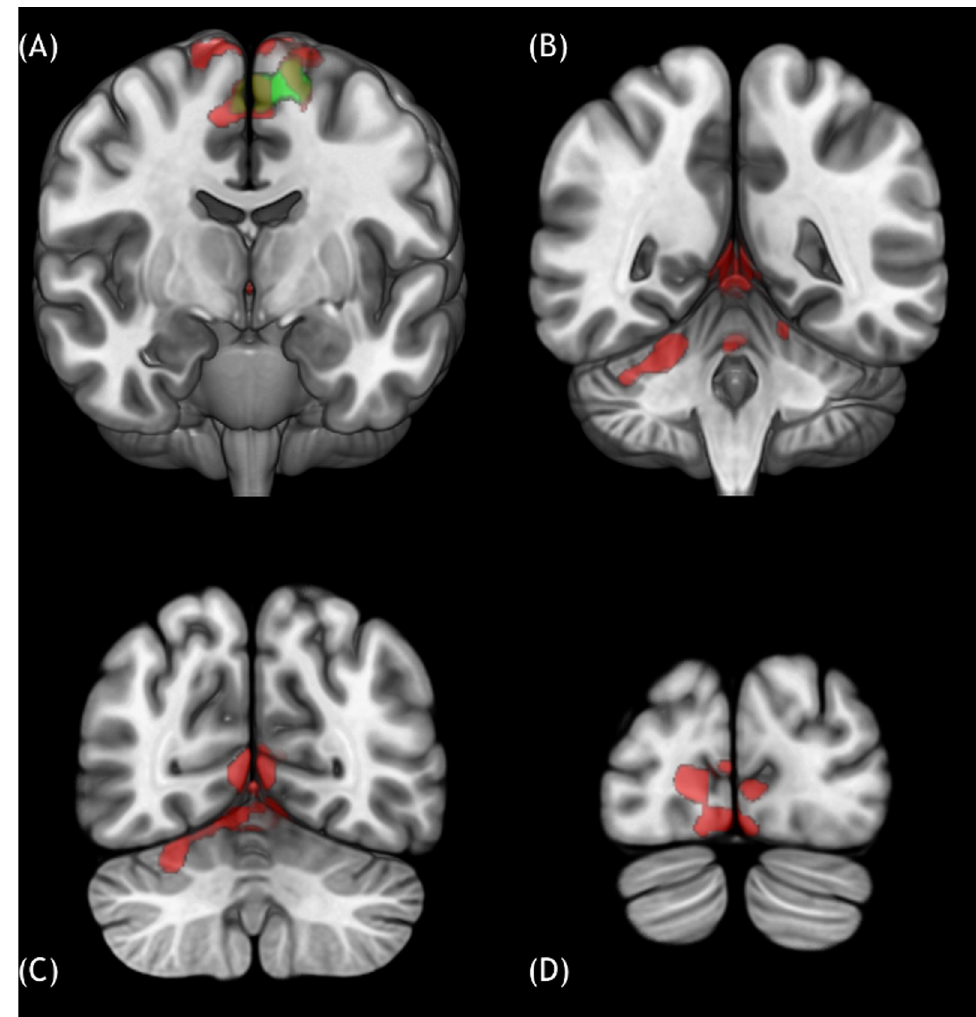
Fig 2. Cortical and cerebellar activated clusters for the two contrasts of interest ‘GAIT–WALKWAY’ and ‘GAIT DOORWAY–WALKWAY DOORWAY’. The contrasts are represented in the MNI152 template space. A, B, C, D: three-dimensional views of the MNI152 template in frontal cross-sections with activated clusters. GAIT-WALKWAY (red) showed clusters in the bilateral motor cortices (A) including the SMA, premotor and motor cortices (BA 4–6), and the cerebellum (left lobe VI, bilaterally in the lobes I-IV, V, and in the vermis VI) (B, C). Activations were also found in the right occipital lobe (BA 17–18) (D). GAIT DOORWAY-WALKWAY DOORWAY (green) showed activated clusters only in the SMA, premotor and motor cortices (BA 4–6)